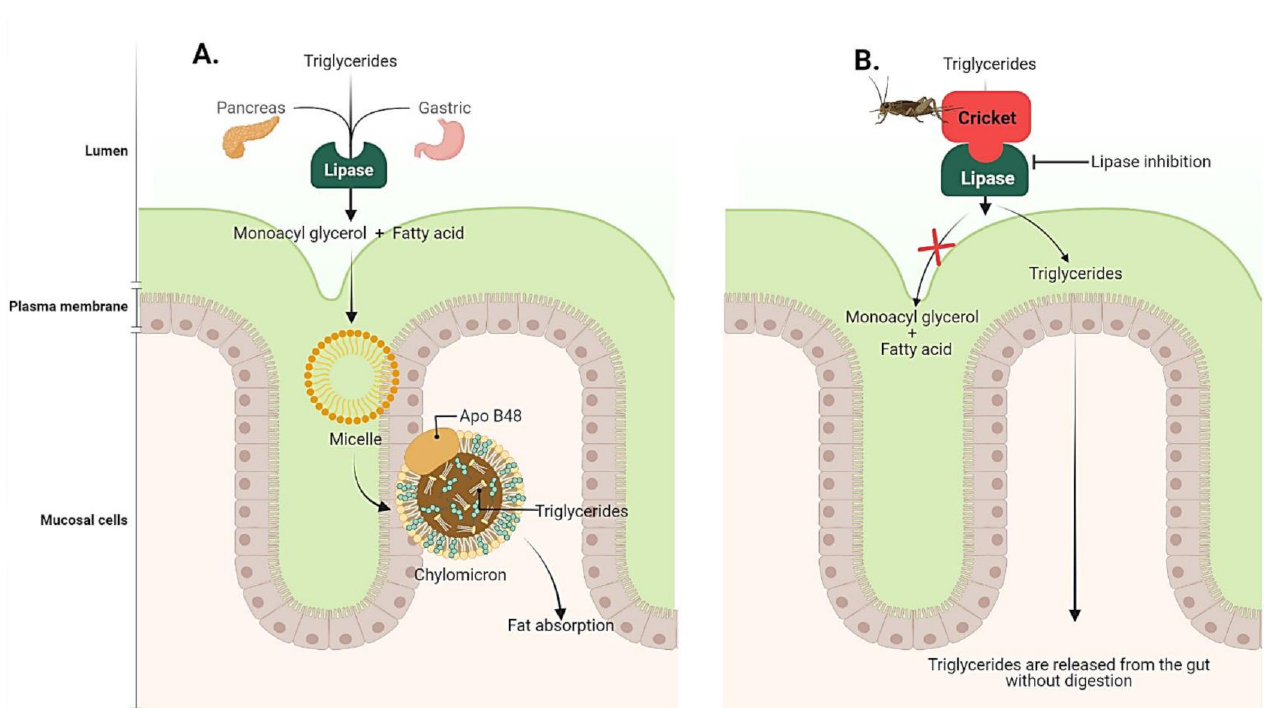
Figure 5. Digestion and absorption of triglycerides by lipase. ( A ) Dietary triglycerides are digested by lipase, which will be subsequently absorbed. ( B ) Lipase inhibition by cricket extract resulted in no absorption of